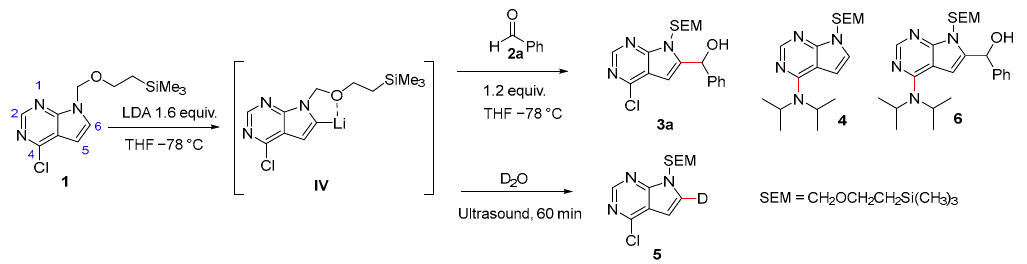
Table 1. Effect amount of LDA, toluene and additives on the lithiation